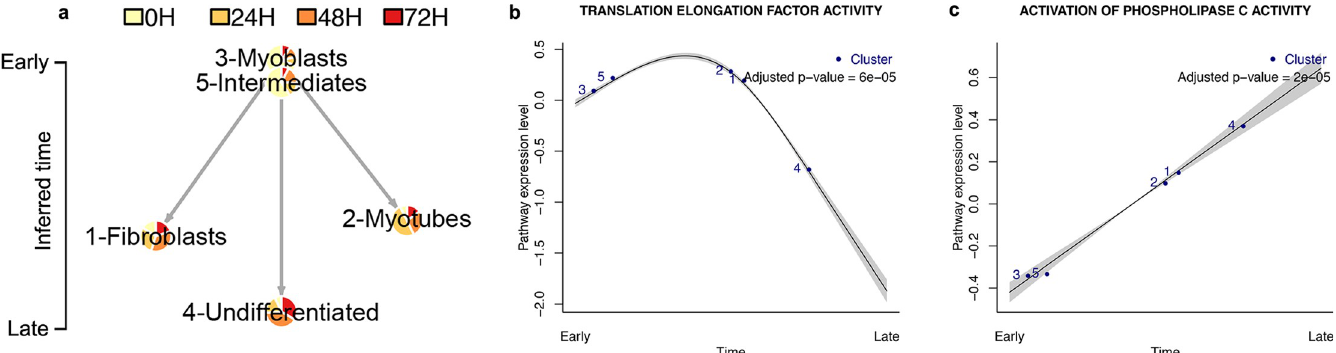
Fig 2. Tempora analysis of the HSMM data set. a. Tempora trajectory built on clusters in the HSMM data set. b-c. Time-dependent pathways in the HSMM data set identified by Tempora’s pathway exploration feature. Blue dots represent clusters/cell types, the black line is the best fit of a generalized additive model (GAM) on the pathway enrichment scores of each pathway across all clusters, and grey areas depict 95% confidence intervals of the fitted model.